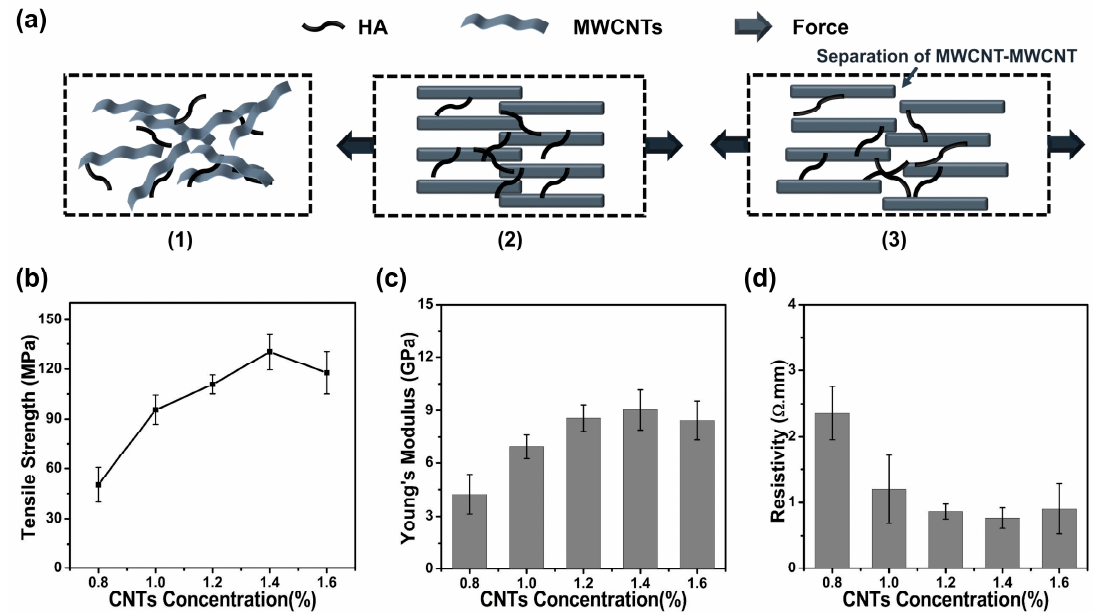
Figure 6. Mechanical properties and resistivities of the HA/MWCNT hybrid microfibers produced with different MWCNT concentrations. ( a ) The fracture mechanism model of the HA/MWCNT hybrid microfibers under tensile stress; ( b ) Tensile strength; ( c ) Young’s Modulus; ( d ) Resistivity.